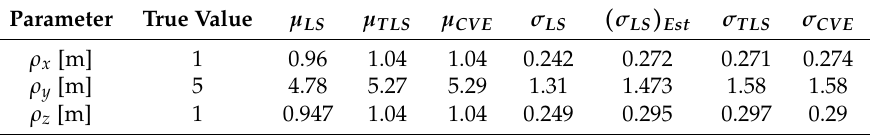
Table 2. Monte-Carlo results summary, 2 cameras.